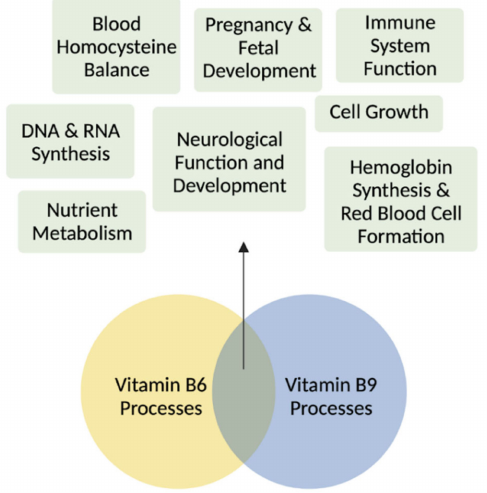
Figure 4. Vitamins B6 and B9 are essential in development and in adult tissues. Vitamin B6 and folate are involved in the biosynthesis of nucleotides for DNA and RNA synthesis, cell growth, neurological development during pregnancy and infancy, hemoglobin synthesis and red blood cell formation, blood homocysteine balance, immune system functioning, and nutrient metabolism. Figure made with